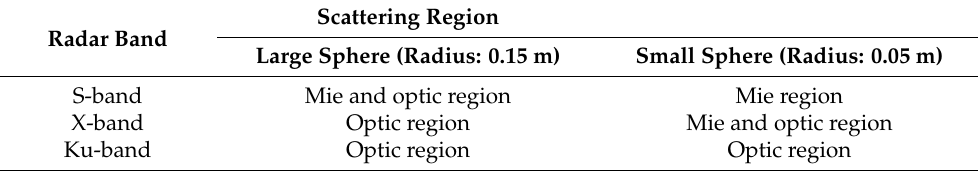
Table 2. Radar bands and sphere